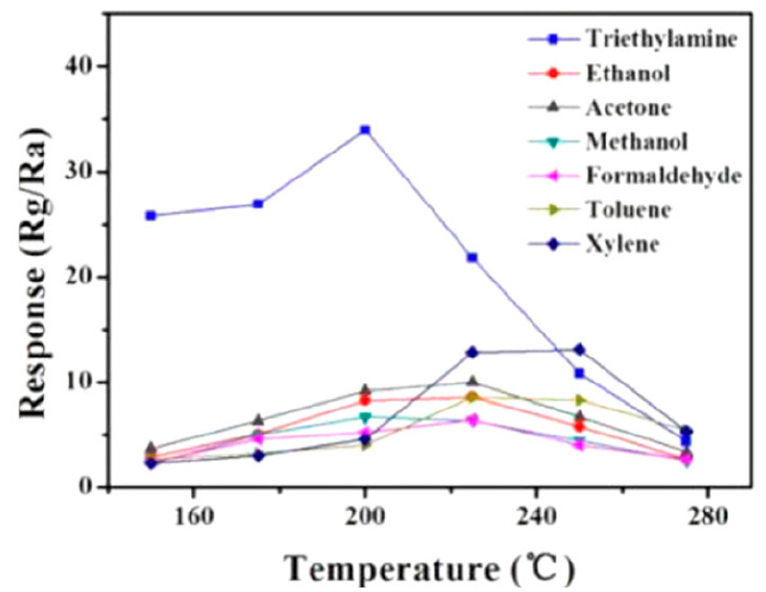
Figure 14. The selectivity of In 2 O 3 -NiO composites to seven different VOCs at various temperatures [108].